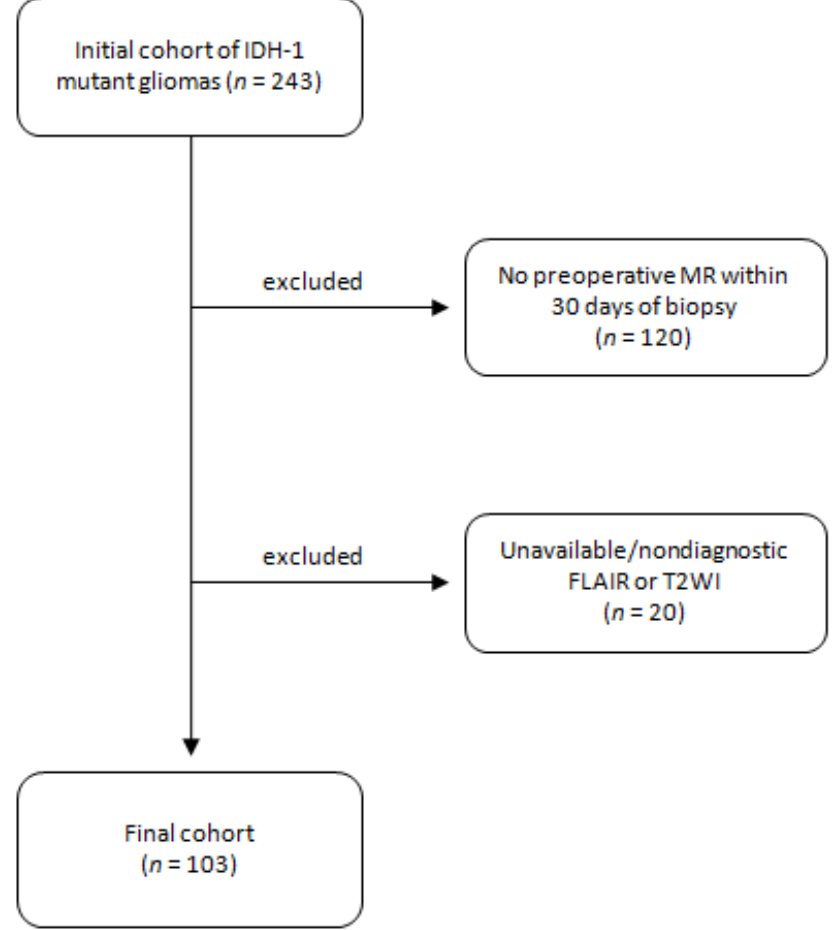
Figure 1. Study diagram with initial cohort and inclusion/exclusion criteria.